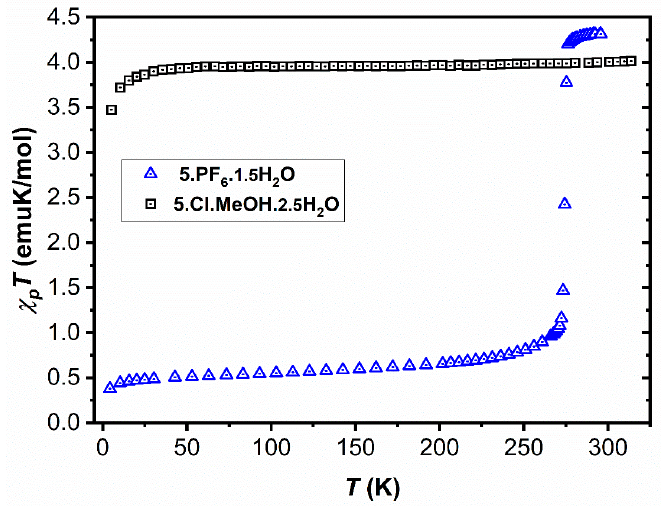
Figure 4. Temperature dependence of the χ P T product in a field of 0.05 T.